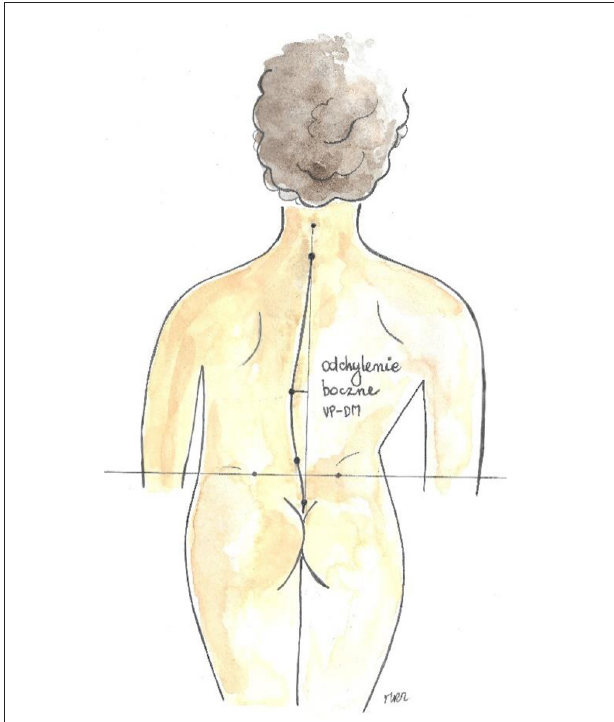
FIGURE 9 | Lateral deviation (own